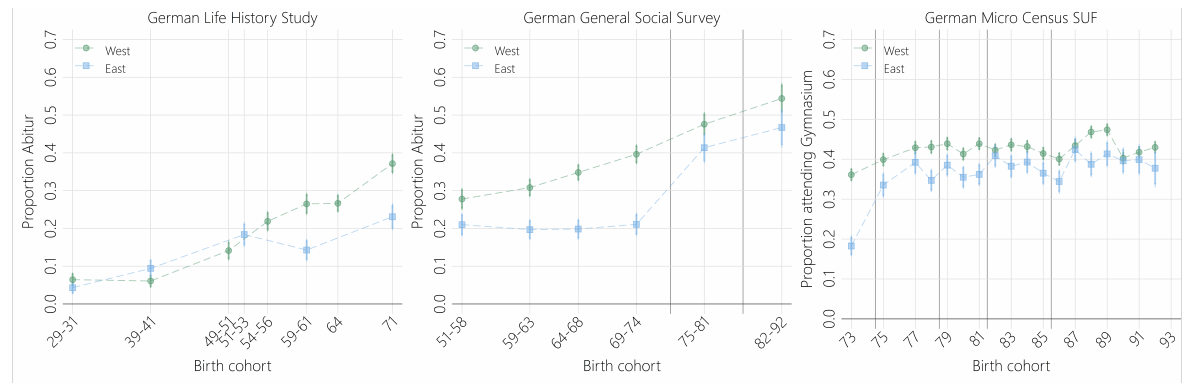
Figure 2: Change in percentage of Abitur attainment (GMC: proportion attending Gymnasium) across birth cohorts in East and West Germany. The first vertical line indicates the timing of reunification. Subsequent vertical lines differentiate birth cohorts according to the timing of educational transitions after